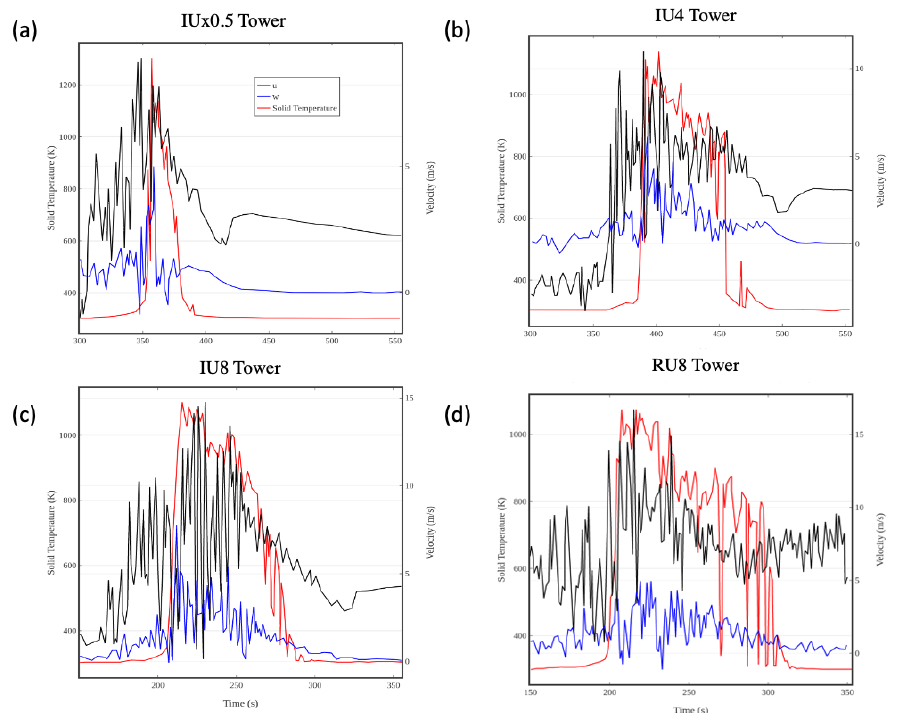
Figure 6. Non-stationary tower plots of solid temperature (red lines), horizontal wind velocity (black lines) and vertical wind velocity components (blue lines). Panel titles indicate the simulation cases being depicted. ( a ) IUx0.5 Tower ( b ) IU4 Tower ( c ) IU8 Tower ( d ) RU8 Tower.